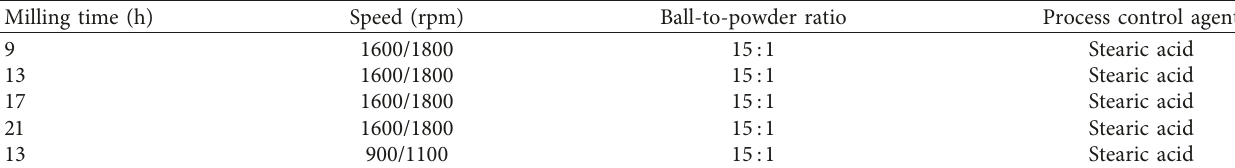
Table 1: Milling process parameters of HCX-1.